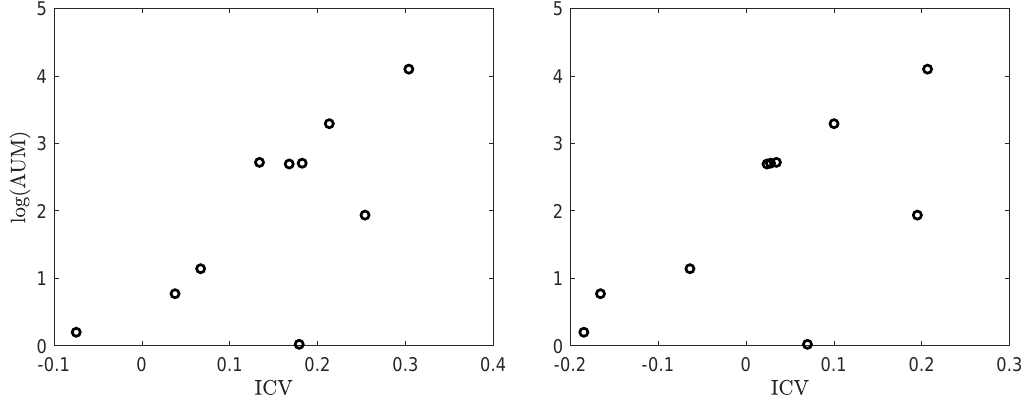
Figure 5: ICV against the natural logarithm of the assets under management of the mutual funds with respect to the S&P 500 (left) and the Russell 1000 (right).